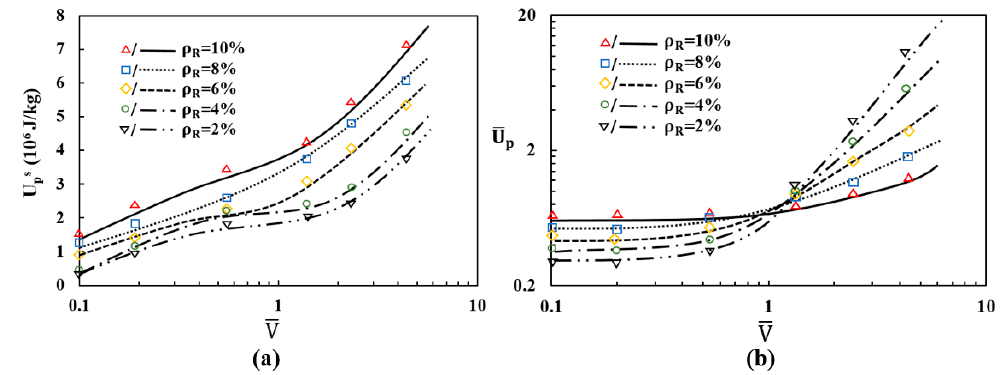
Figure 13. ( a ) Specific plastic energy dissipation U s p versus the normalized crushing velocity V; ( b ) Normalized plastic energy dissipation U p versus the normalized crushing velocity V .